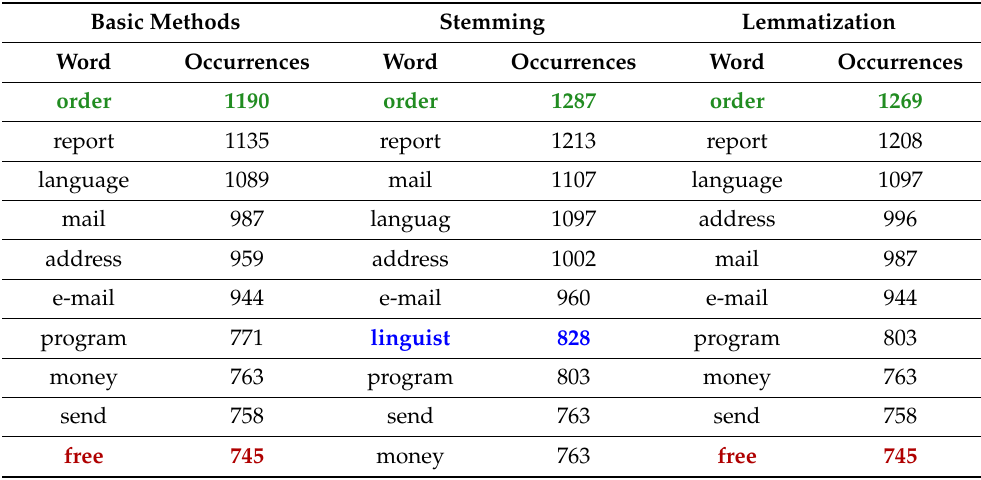
Table 11. Ten most common features for dataset 4.